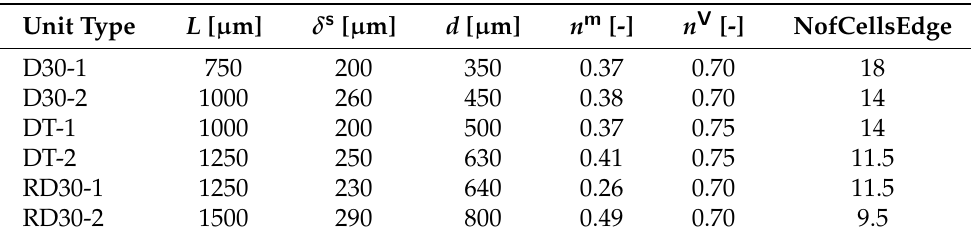
Table 1. Types and geometry of basic trabecular cell units (D30—diamond, relative density